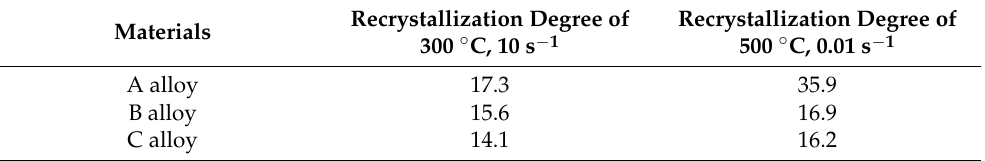
Figure 6. The processing maps of the three alloys and the corresponding microstructures ( ε = 1.0) of/at ( a ) Alloy A; ( b ) 300 °C − 10 s − 1 ; ( c ) 500 °C − 0.01 s − 1 ; ( d ) Alloy B; ( e ) 300 °C − 10 s − 1 ; ( f ) 500 °C − 0.01 s − 1 ; ( g ) Alloy C; ( h ) 300 °C − 10s − 1 ; ( i ) 500 °C − 0.01 s − 1 . Table 2. Recrystallization degree of 3 alloys after thermal deformation